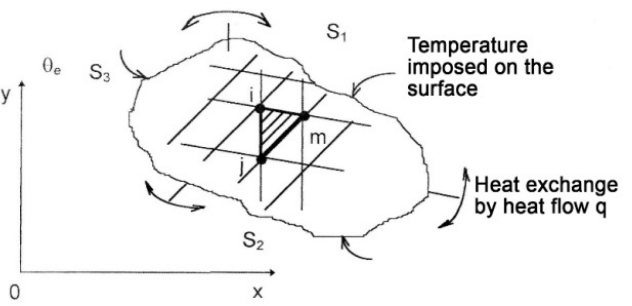
Figure 2. General case of the two-dimensional heat exchange of a body with the surrounding environment, where S 1 , S 2 , S 3 are surfaces; I , j , m are versors; and θ e is the temperature of the surrounding